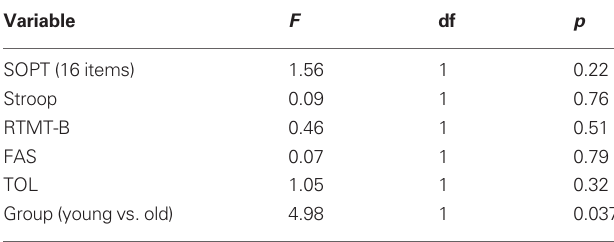
SOPT, Self Ordered Pointing Task; Stroop, Stroop Word–Color Interference Test; RTMT-B, Reitan Trail Making Task Part B; FAS, Controlled Oral Word Association Task; TOL, Tower of London